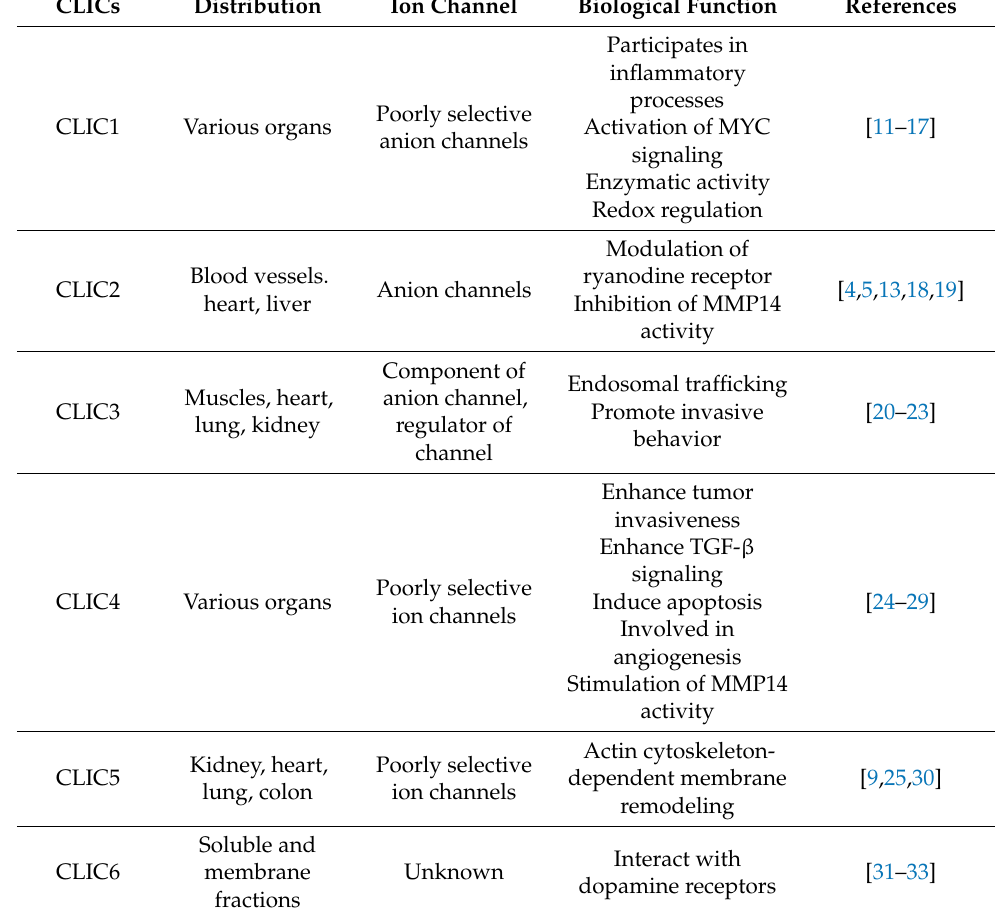
Table 1. CLICs: their distribution, ion channel activities, and biological functions. CLICs